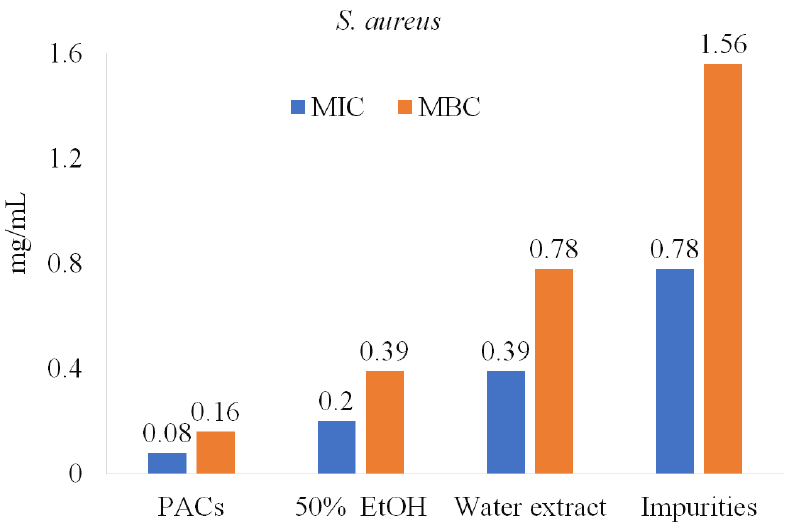
Figure 6. PACs’ role in anti-bacterial activity against S. aureus . Oral candidiasis is a common fungal disease caused mainly by C. albicans . When comparing the anti-fungal activity of three samples (50% EtOH, water extract, and PACs of ‘Maria Bruvele’), isolated PACs were weaker at the initial stage. The following MIC tendency was observed: 50% ethanol extract (0.20 mg/mL) > water extract (0.39 mg/mL) > PACs (1.25 mg/mL) (Table 3).